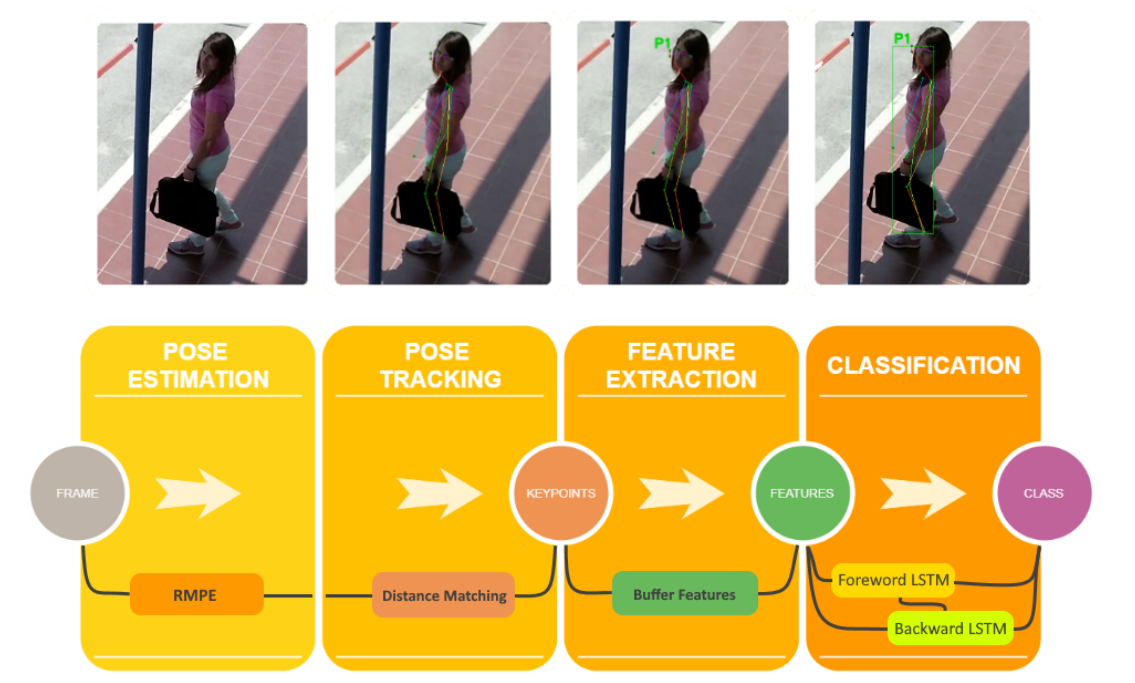
Figure 3. Pipeline of the pose